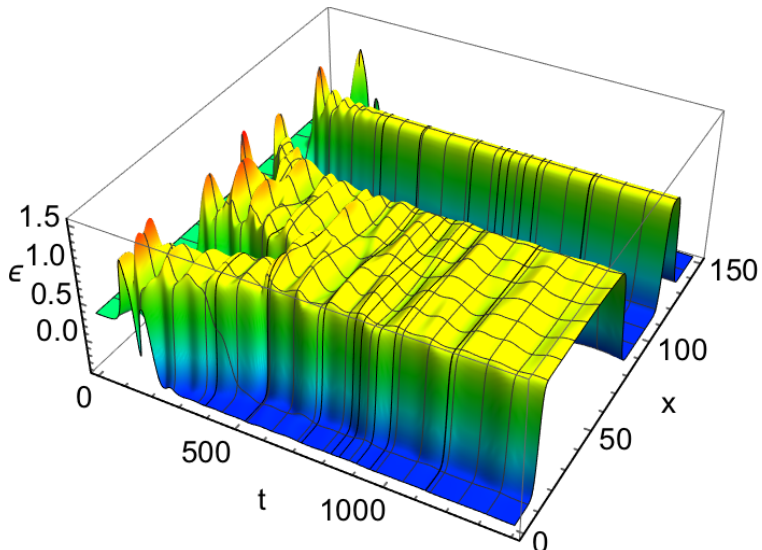
Figure 4 . Space and time dependence of energy density for a con(cid:12)guration with (cid:11) = 0 : 1 displaying eight high temperature domains in the initial